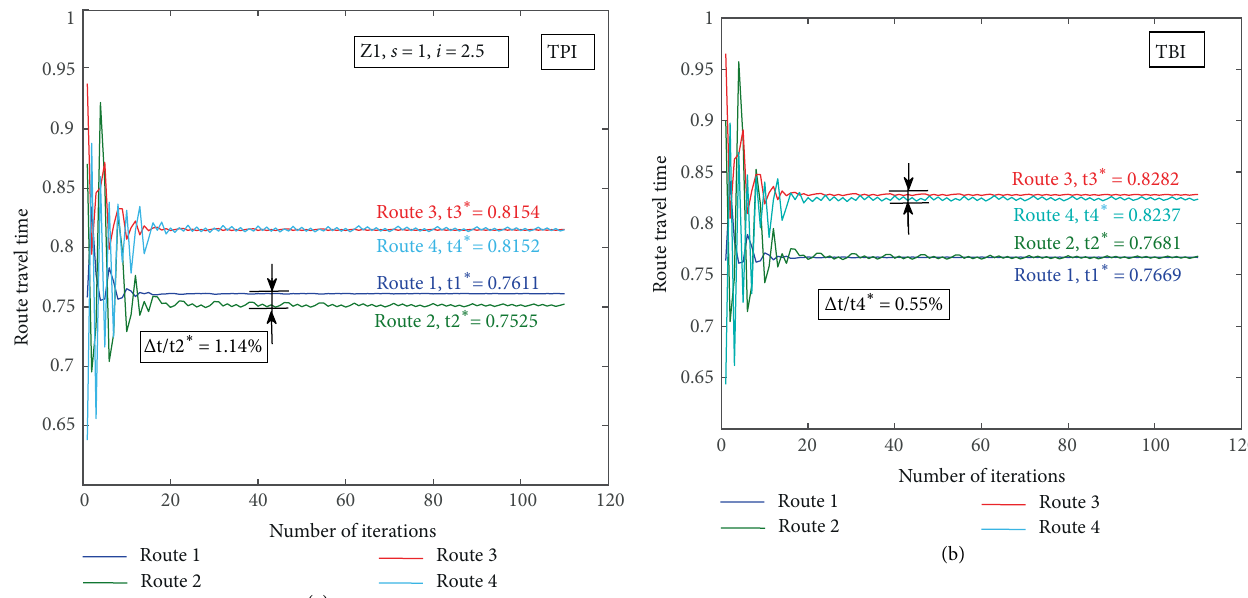
Figure 6: Convergence curves of ARTT of TPI and TBI (Z1, curves of PRTT of TBI (Z1, s =